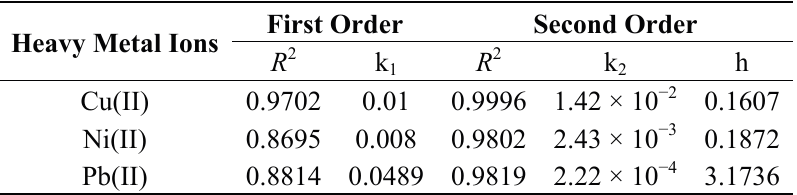
Table 6. Parameter of the kinetics models for the adsorption of Cu(II), Ni(II) and Pb(II) O /talc onto Fe 3 4